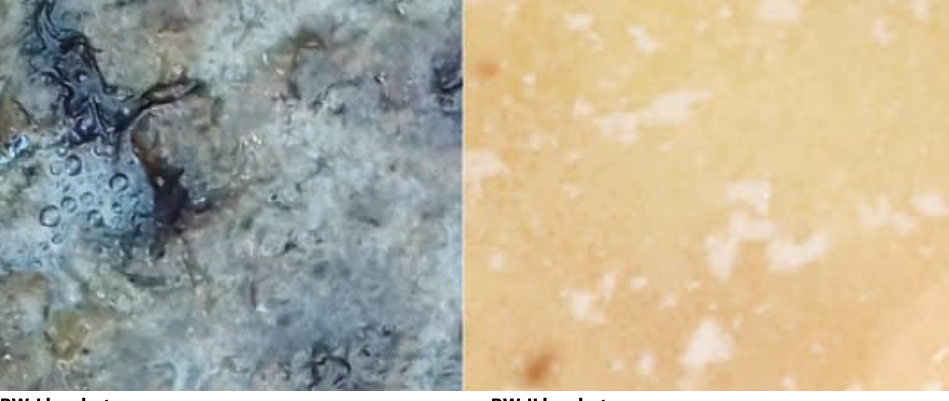
Fig. 1 . Colour and nature of leachate from BW-I and in agreement with our findings. Means having same superscripts (small letter a-e, h-l, v-z within columns, capital letters A-E, H-L, V-Z within rows) did not differ significantly at 5 per cent level. The pH changes observed during